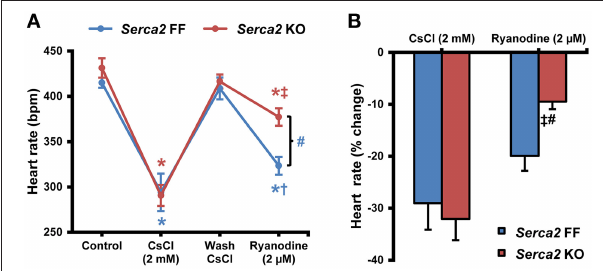
FIGURE 5 | Sinus node pacemaking in Serca2 FF vs. Serca2 KO mice. (A) Change in heart rate of isolated sinus node preparations from Serca2 FF and Serca2 KO in response to treatment with 2 mM CsCl and 2 µ M ryanodine. (B) Percentage reduction of heart rate in vitro induced by CsCl (2 mM) and ryanodine (2 µ M) treatment. The CsCl (2 mM) and ryanodine (2 µ M) measurements are presented as percentage of control and wash CsCl values, respectively. Serca2 FF data are shown in blue and Serca2 KO data are shown in red color. * , † , and ‡ represent P < 0.05 vs. control, wash CsCl and CsCl (2 mM) respectively. Blue symbols are used for Serca2 FF and red for Serca2 KO data. # represents P < 0.05 vs. Serca2 KO ryanodine response ( Serca2 FF, n = 8 and Serca2 KO, n =